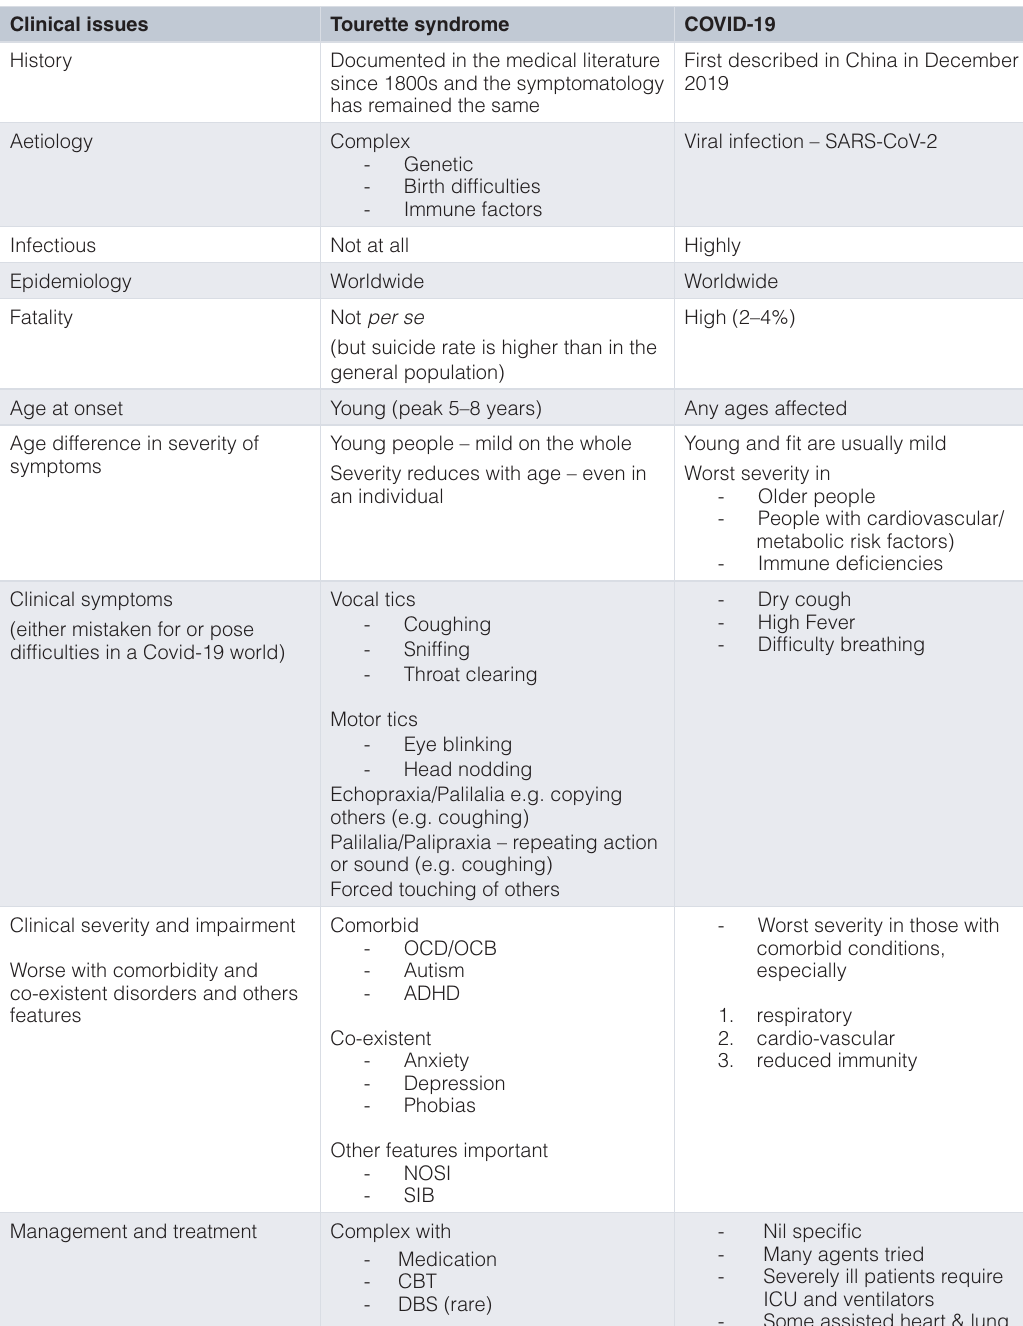
Table 1. Summary of the demography and clinical features of GTS and